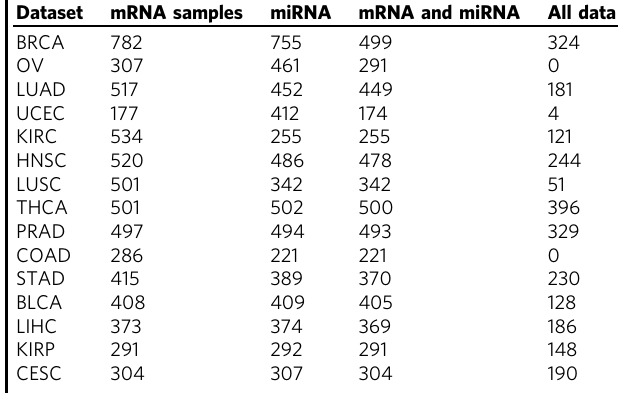
Table 2 TCGA datasets considered and associated total clinical sample counts Dataset